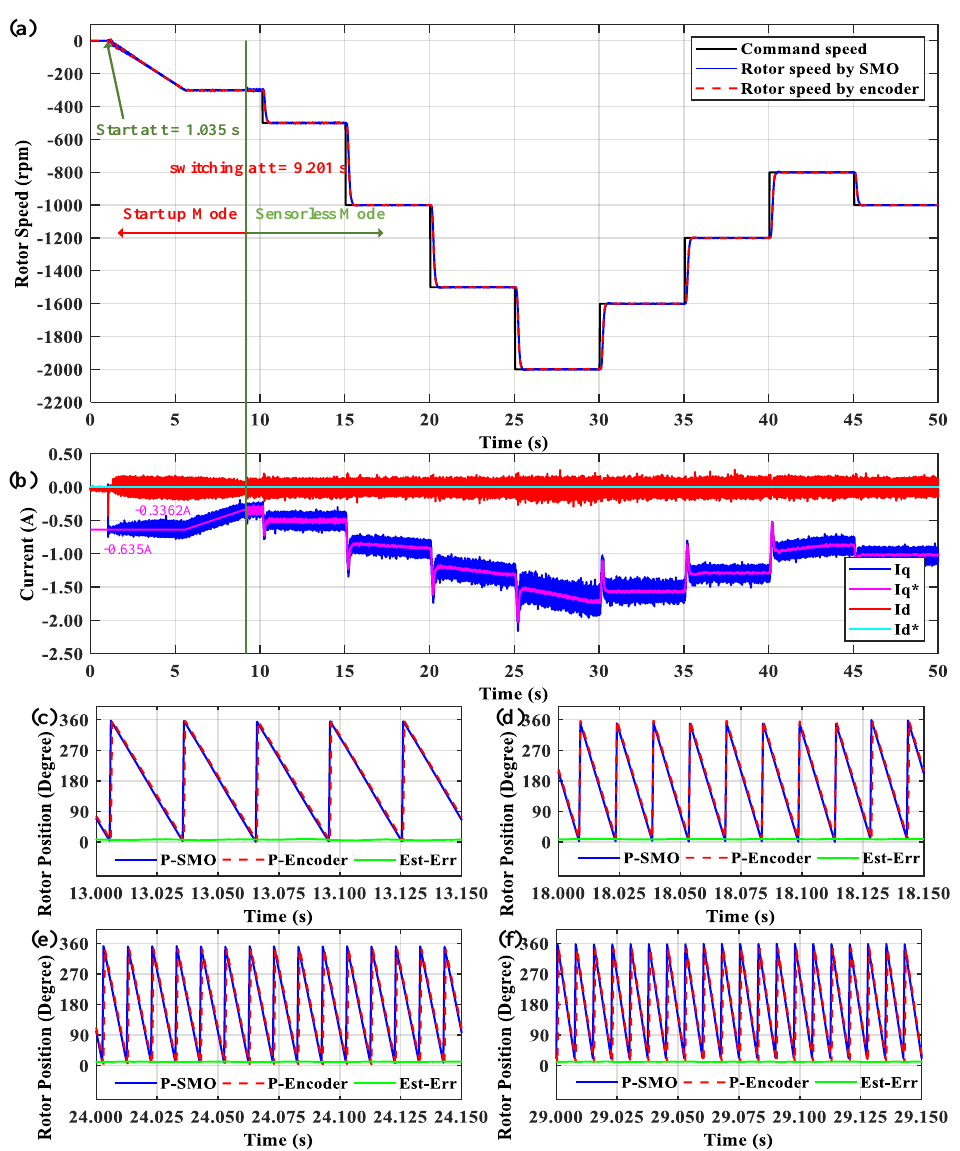
Figure 17. Experimental results in the wide speed range in the negative direction: ( a ) speed response; ( b ) current response; and rotor position response at: ( c ) 500; ( d ) 1000; ( e ) 1500; and ( f ) 2000 rpm.